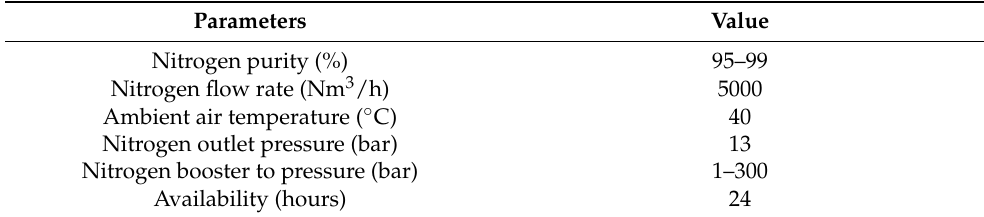
Table 1. Properties and specification of (N 2 ) product model: PN-capacity-purity (PN-060) high- capacity PSA nitrogen generation plants.